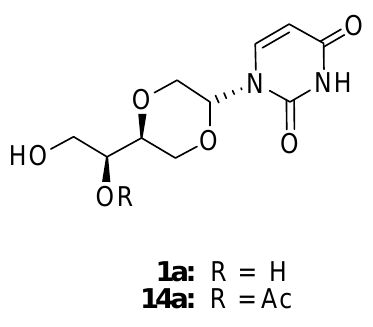
Figure 2. Trans- uridine analogs 1a and 14a